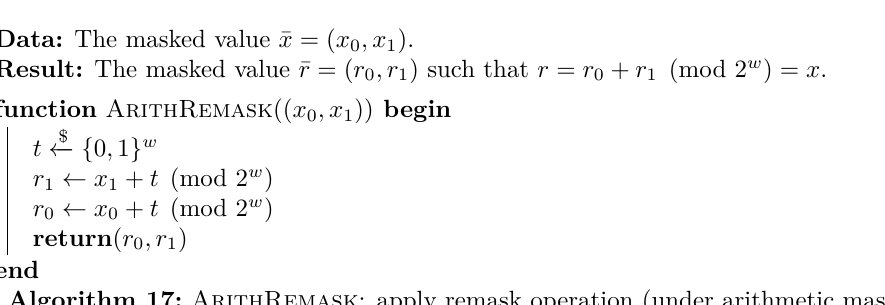
Algorithm 17: ArithRemask : apply remask operation (under arithmetic masking).